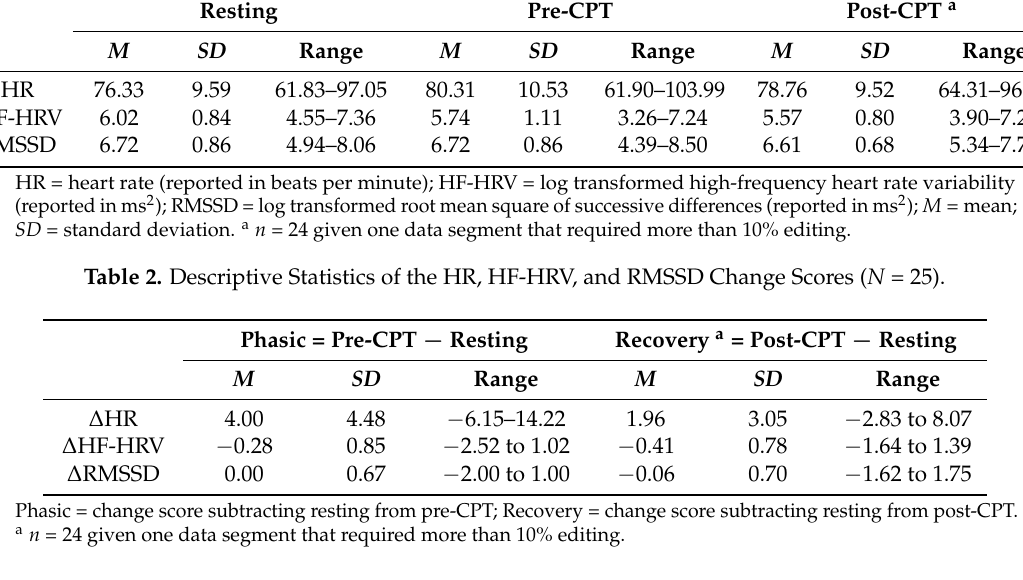
Table 1. Descriptive Statistics of HR, HF-HRV, and RMSSD during Resting, Pre-CPT, and Post-CPT ( N = 25). Resting Pre-CPT Post-CPT a M SD Range M SD Range